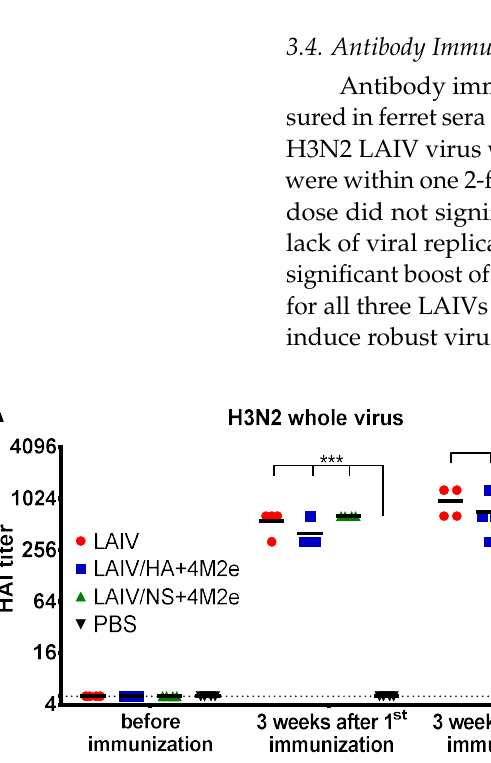
Figure 6. Hemagglutination inhibiting (HAI) antibody titers in ferrets immunized with studied LAIV viruses. Ferret sera were collected three weeks after the first and the second intranasal immunization. The antibody titers were assessed in HAI assay using the H3N2 LAIV ( A ) or S.A. H1N1 ( B ) whole virus as an antigen. Data were analyzed by two-way ANOVA with Tukey’s post-hoc multiple analyses test. ** p < 0.01; *** p < 0.001.